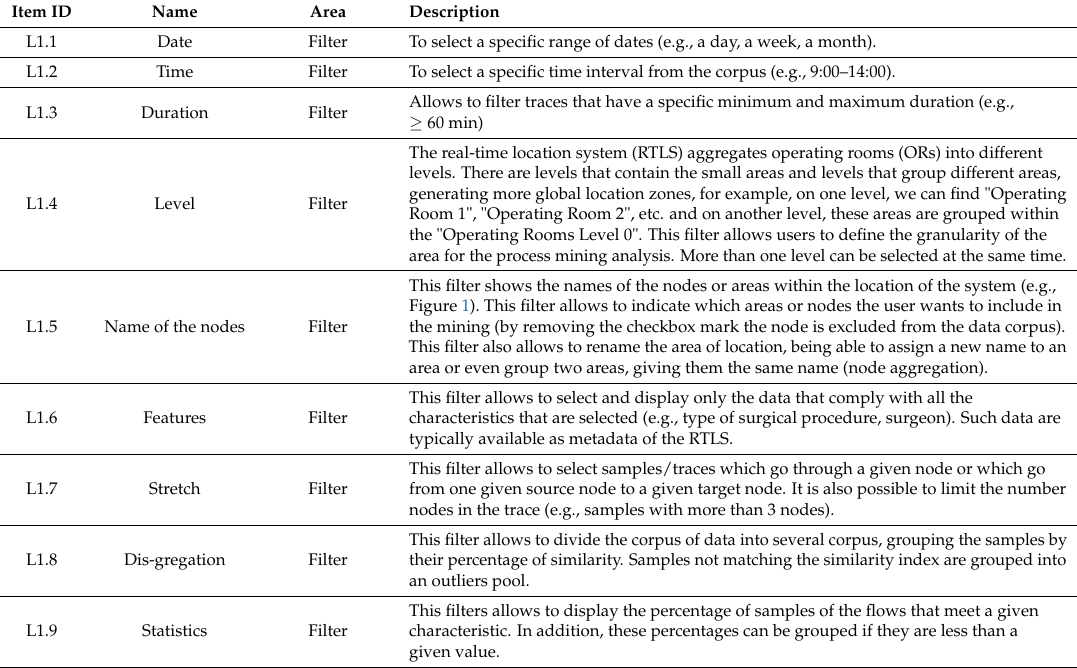
Table 1. Structure and items of the filters area in the process mining dashboard under evaluation.